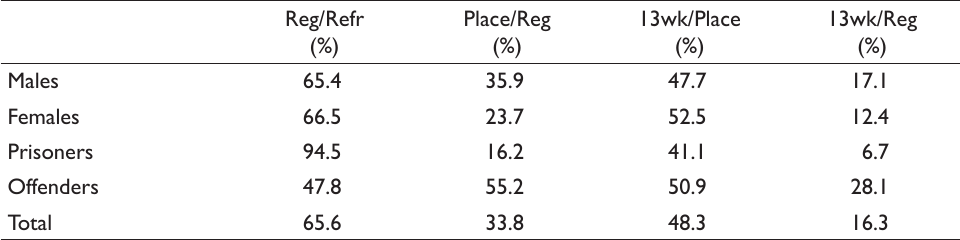
Table 1: Progression of employment among participants